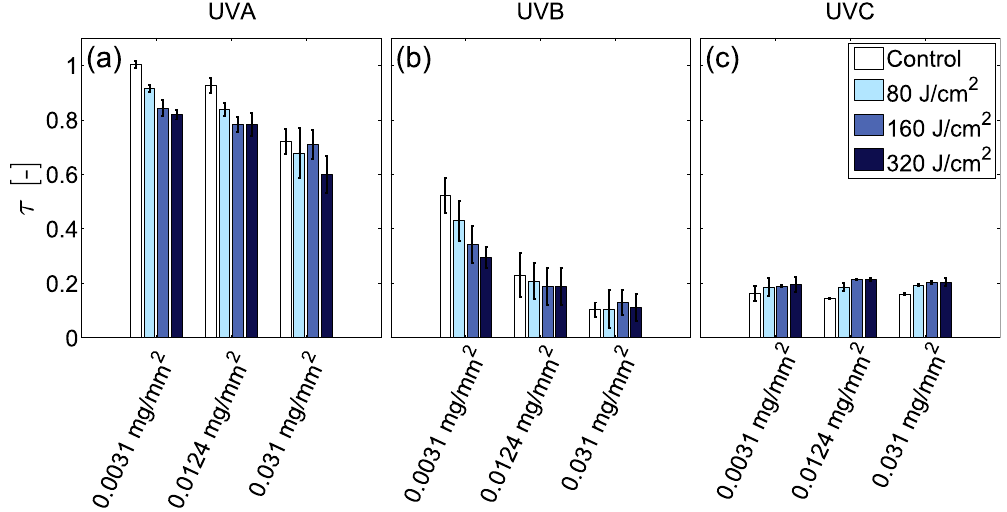
Figure 6. Effect of UVA dosage on UV film transmittance. Average DNA film transmittance, τ , in the ( a ) UVA range (315–400 nm), ( b ) UVB range (280–315 nm) and ( c ) UVC range (200–280 nm) prior to UVA exposure (open bar) and after UVA irradiation with dosages of 80, 160 and 320 J/cm 2 (respectively denoted by increasingly dark bar colors). Error bars denote standard deviations of n = 3 individual